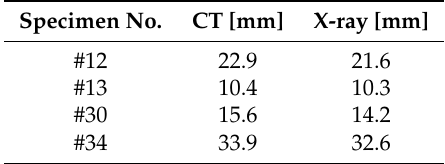
Figure 13. X-ray examination of large-scale specimen #30. Table 4. Total lengths of selected macroscopic shrinkage